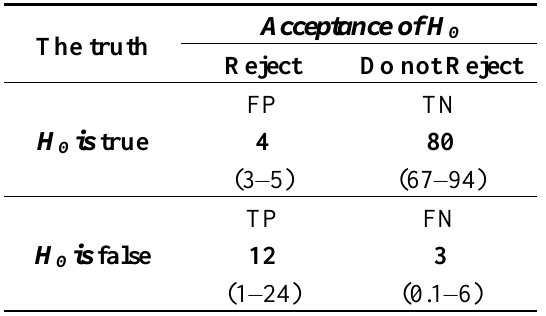
Table 1. Expected rates of different outcomes of study considered in Figure 9 (percent: median, (2.5 to